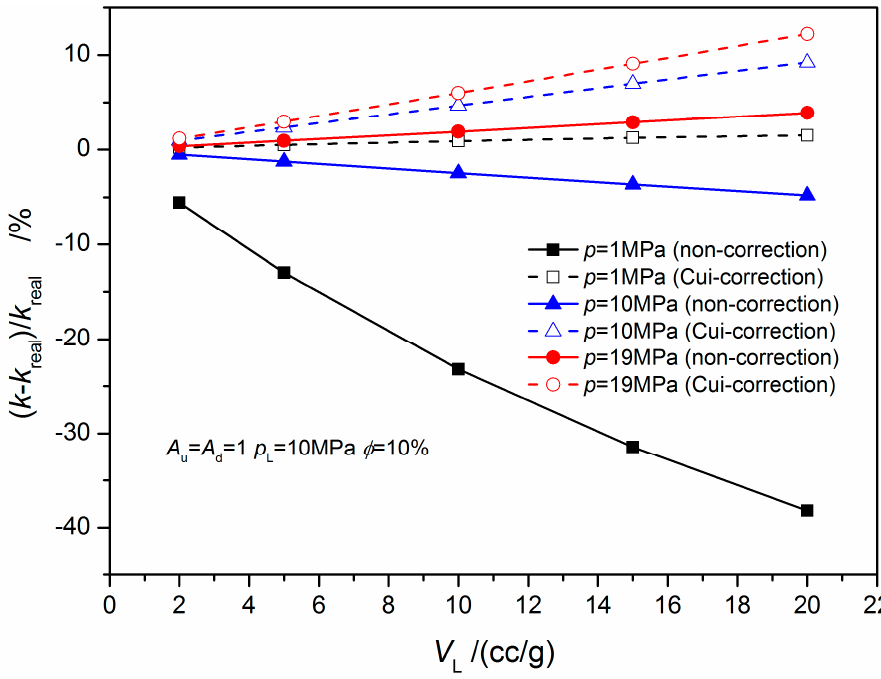
L on the tested permeability. Energies 2019 , 12 , x FOR PEER REVIEW